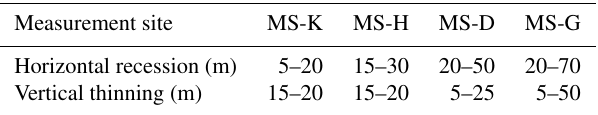
Table 1. Horizontal recession and vertical surface lowering rates of the glacier areas in the four subregions of interest (Fig. 1) between 1915 and